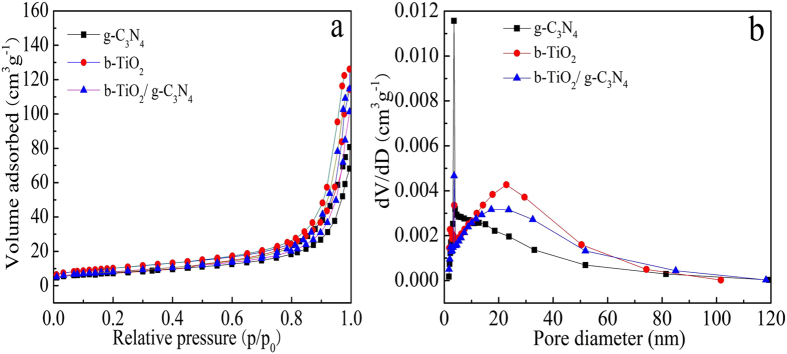
N2-adsorption/desorption isotherm curves (a) and BJH pore size distribution plots (b) of g-C3N4, b-TiO2, and b-TiO2/g-C3N4, respectively.